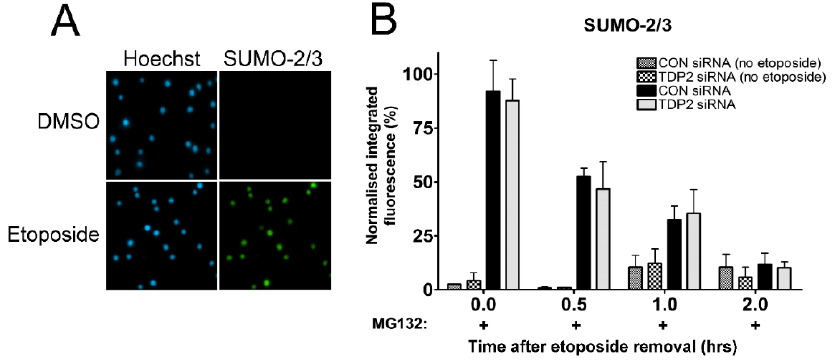
Figure 5. Effect of TDP2 siRNA knockdown on levels of SUMOylated TOP2-DNA complexes following proteasomal inhibition. ( A ) K562 cells were treated with 100 µ M etoposide (or equivalent volume of DMSO) for 2 hours, and SUMOylated TOP2-DNA complexes were visualized using the TARDIS assay; ( B ) Control or TDP2 siRNA knockdown cells were treated with 100 µ M etoposide and 10 µ M MG132 for 2 h, followed by incubation in etoposide-free medium containing MG132 for 0, 0.5, 1, or 2 h. Levels of SUMOylated TOP2-DNA complexes were measured using the TARDIS assay. Values are normalised to a 2 h 100 µ M etoposide control and compared by two-way ANOVA ( n =